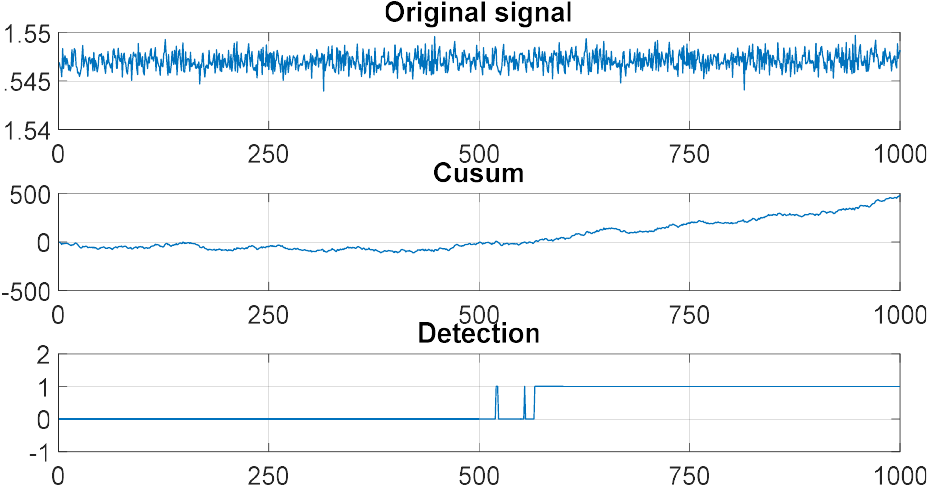
Figure 12. Fault detection results with the variance value.